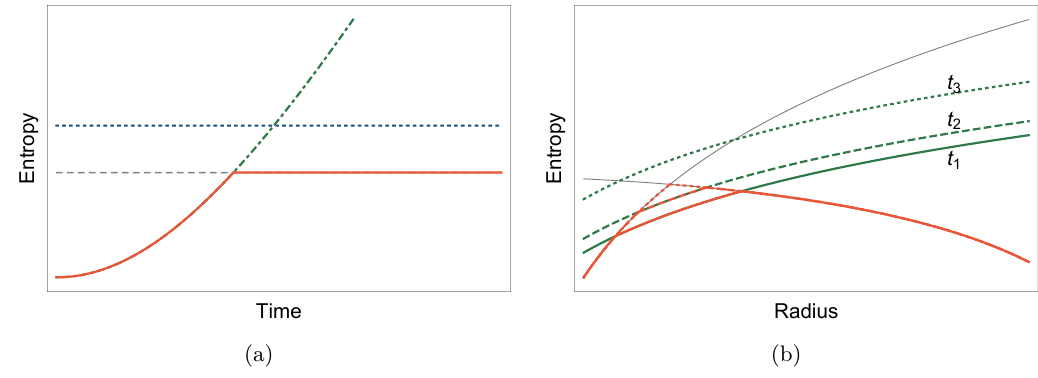
Figure 9 . (a) The entropy of a subsystem as a function of time (red solid line). The green dashed line is the temperature dependent term, which scales as cosh 2 πt/β while the horizontal lines correspond to the time independent terms in the formula for the entropy, eq. (4.59). (b) The entropy as a function of the size of the subsystem, r . The gray lines correspond to the time independent terms in eq. (4.59), and are monotonically increasing/decreasing with r . The green lines correspond to the time dependent part, which increases as time increases ( t smaller times, this contributes non-trivially to the entropy (green solid and green dashed lines), but is irrelevant at later times (green dotted